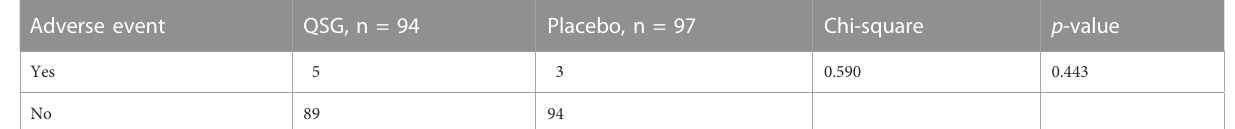
TABLE 10 Adverse event. Adverse event QSG, n = 94 Placebo, n = 97